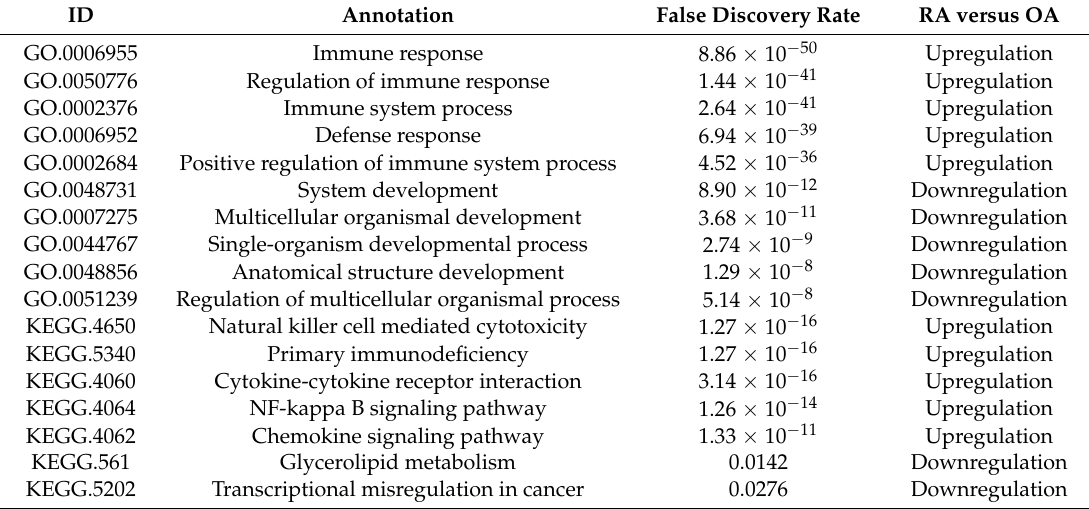
Table 2. Representative Gene Ontology (GO) biological processes and Kyoto Encyclopedia of Genes and Genomes (KEGG) enriched pathways of differentially expressed (DE) genes between RA and